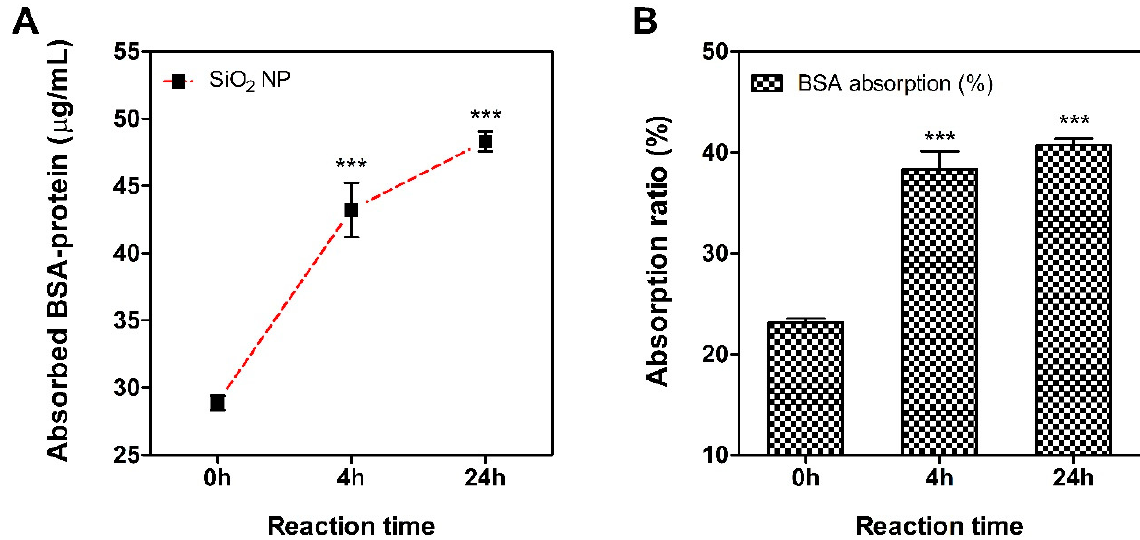
Figure 2. Protein binding affinity of silica nanoparticles using bovine serum albumin (BSA). After reaction with 100 µ g/mL BSA, ( A ) Absorbed BSA protein amount, ( B ) protein absorption rate. Data are expressed as mean ± SEM ( n = 8). *** p < 0.0001 compared to 0h time-point.